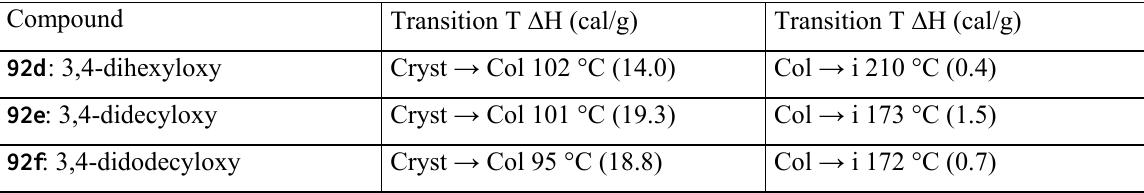
Table 7. Transition temperatures and enthalpies of liquid crystalline tetrastyrylpyrazine cruciforms (DSC, first heating